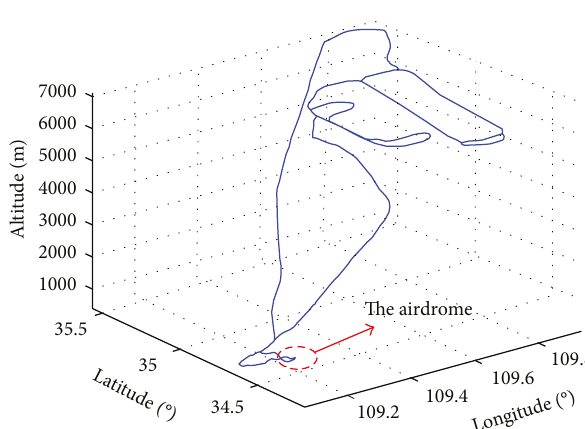
Figure 3: The second-level dynamic lever arm mechanism.